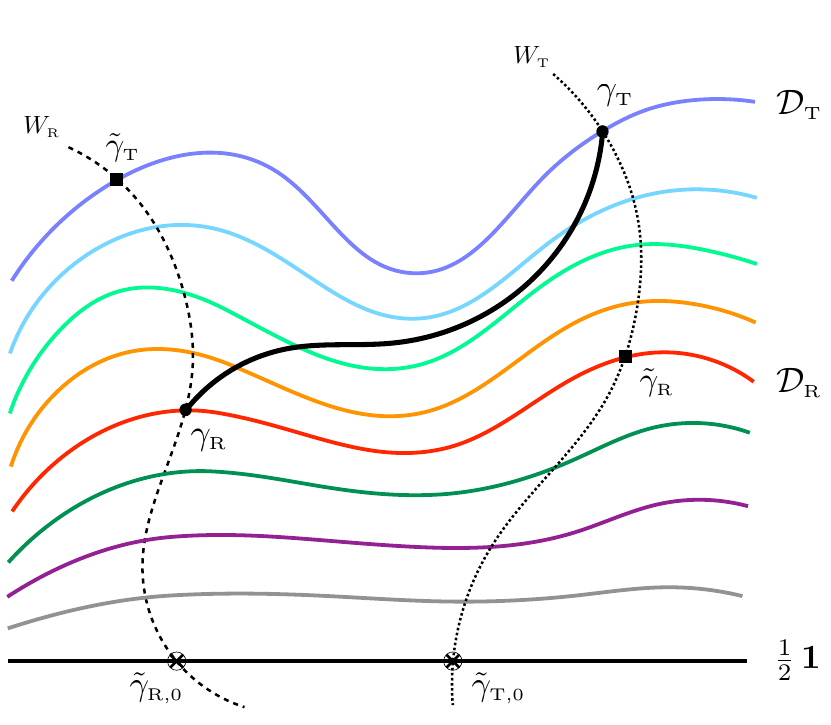
Figure 3 . The optimal purification paths for γ to the W path, that are represented through dashed lines. The straight black solid line represent T the set of the pure states, whose symplectic spectrum is given by D = 1